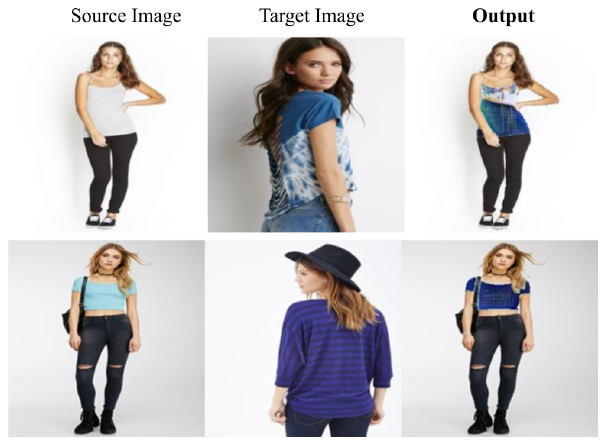
Figure 7. Results with DeepFashion [41] dataset.